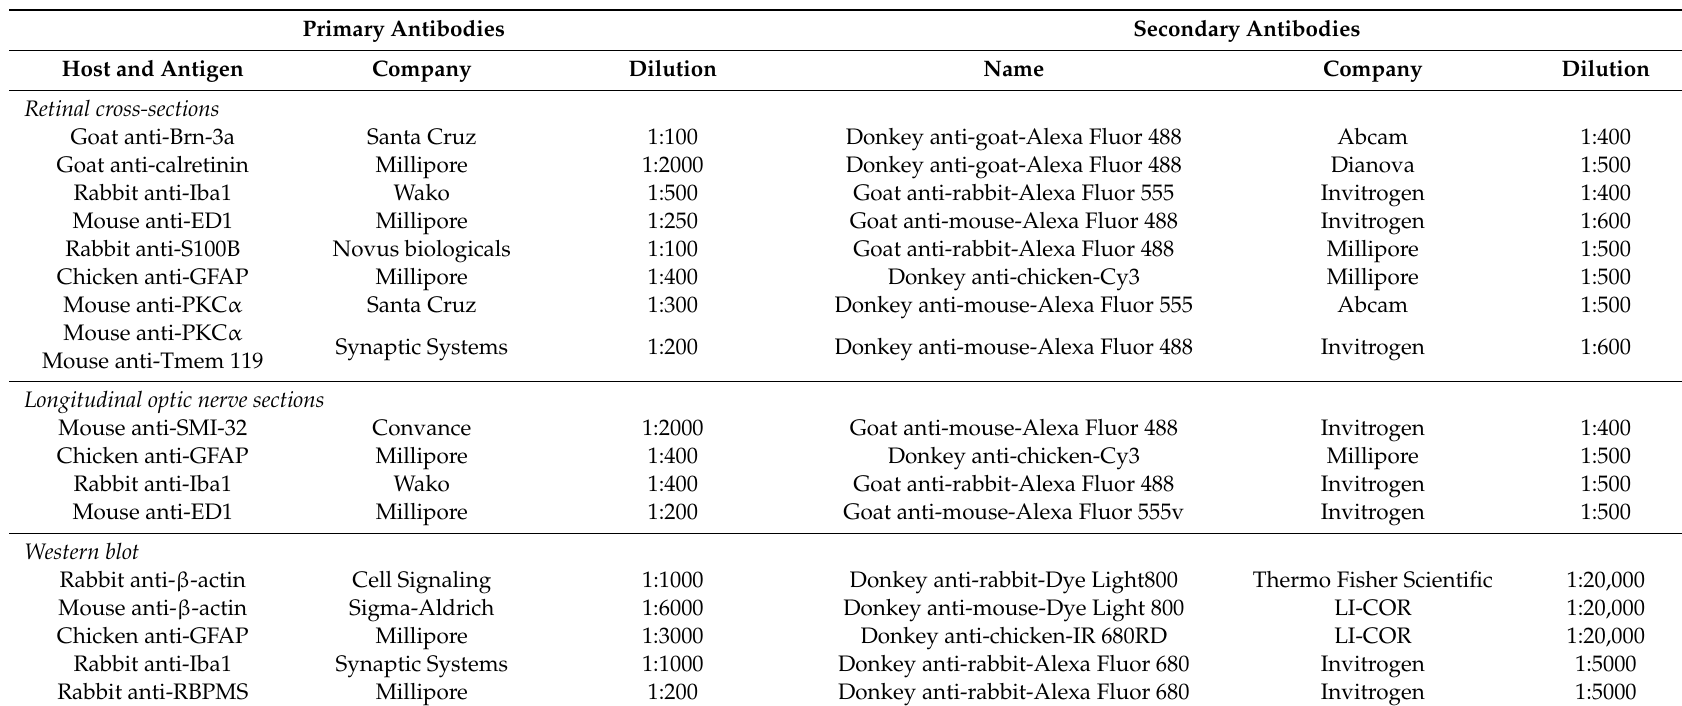
Table 1. Primary and secondary antibodies used for